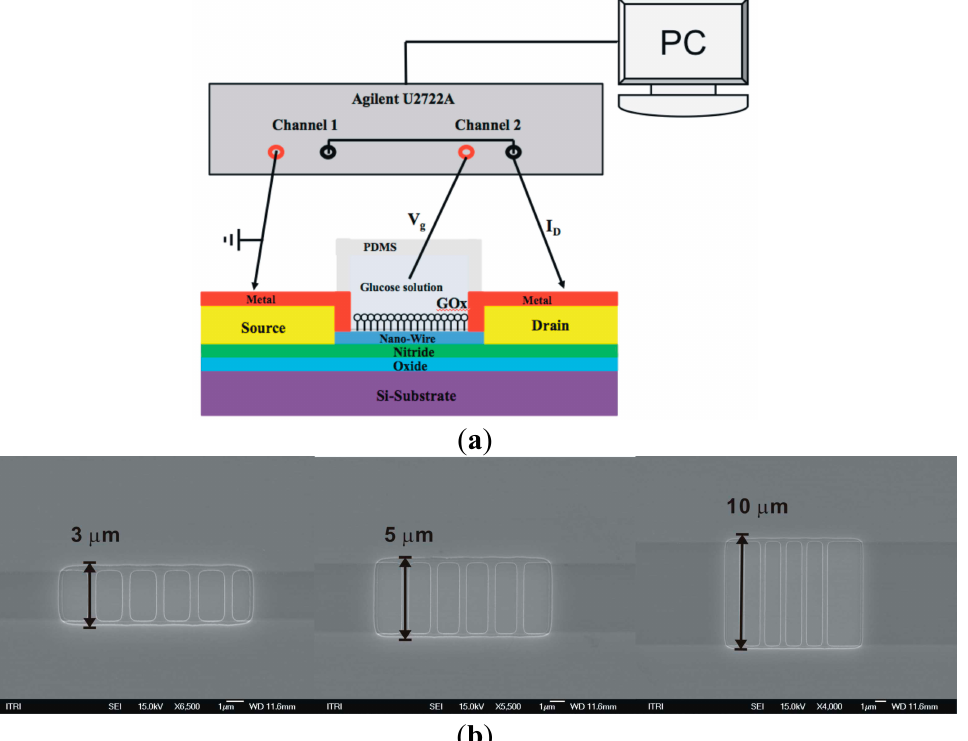
Figure 1. ( a ) Diagram of the device structure and the experimental setup; ( b )